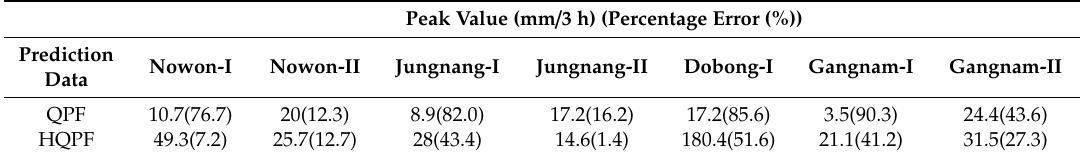
Figure 9. Time series for a 3 h accumulated rainfall at ( a ) Nowon, ( b ) Jungnang, ( c ) Dobong, and ( d ) Gangnam observational sites. Table 5. The intensity of peak precipitation (mm / 3 h) and percentage error (%) by